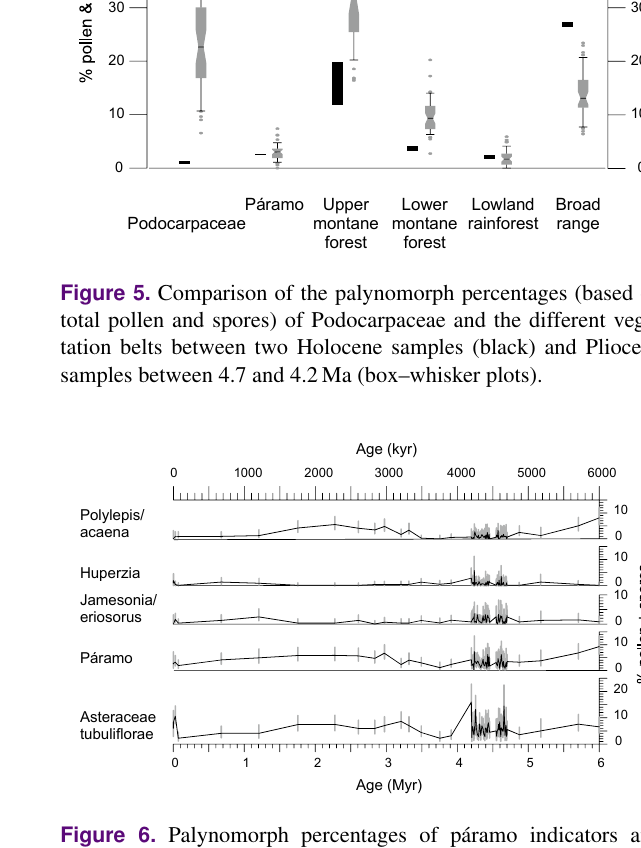
Figure 6. Palynomorph percentages of páramo indicators and Asteraceae Tubuliflorae (excluding Ambrosia/Xanthium T) of the past 6Myr indicating the presence of páramo vegetation at least since the late Miocene. 95% confidence intervals (grey bars) af- ter Maher (1972). Ages after Tiedemann et al. (2007) and Mix et al.